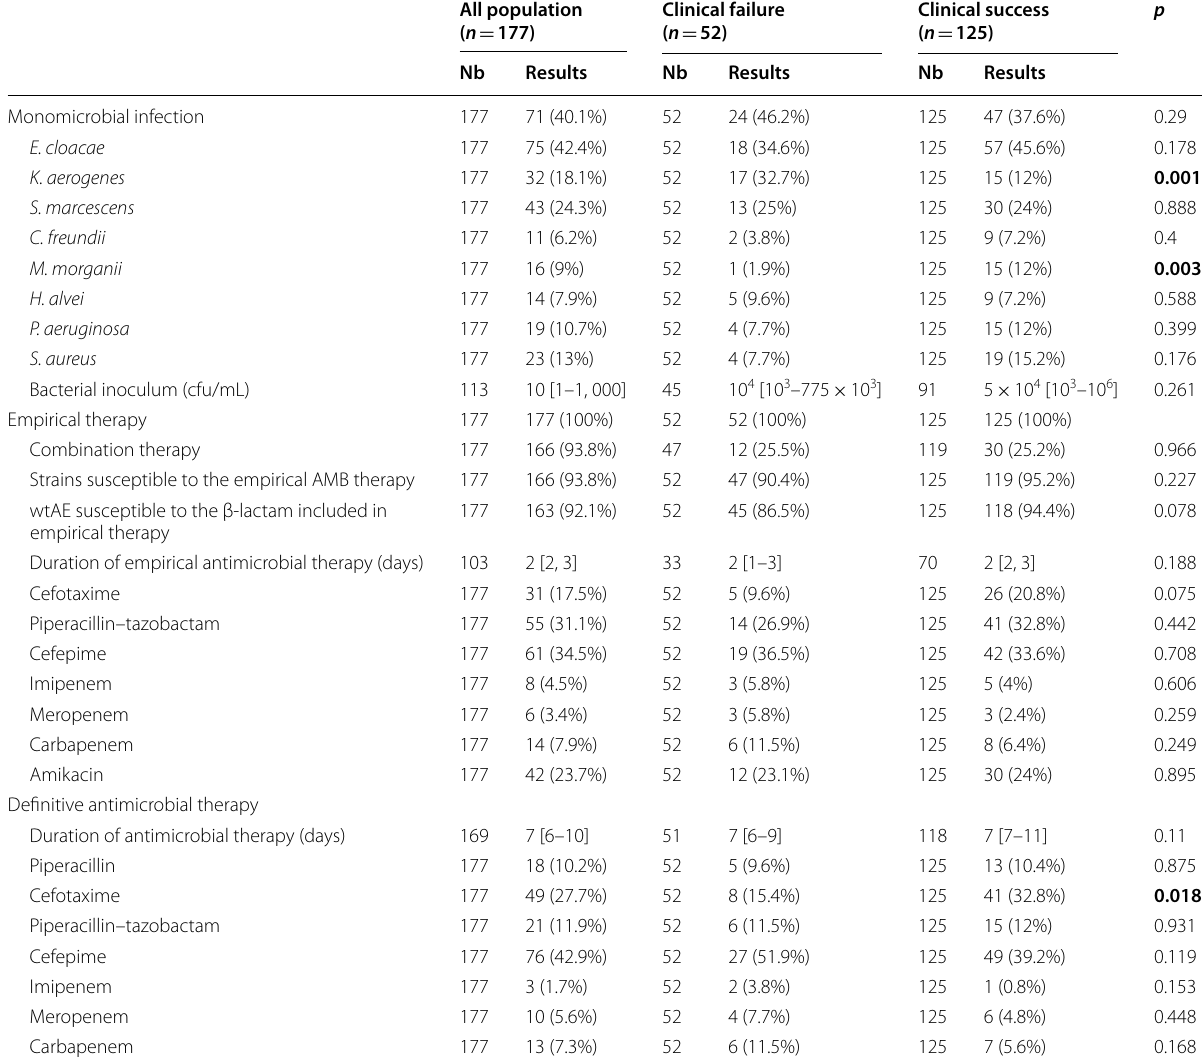
Bacterial inoculum concerns only samples collected by telescopic catheters protected in ventilator-associated pneumonia. Combination therapy means the combination of two antibiotics active in vivo, on the wild-type AmpC-producing Enterobacterales. Regarding empirical therapy, the susceptibility of strains to empirical antimicrobial therapy concerns all strains found in the sample, whether they are wtAE or not AMB: antimicrobial; wtAE: wild-type AmpC-producing Enterobacterales; Nb: number of available values for the